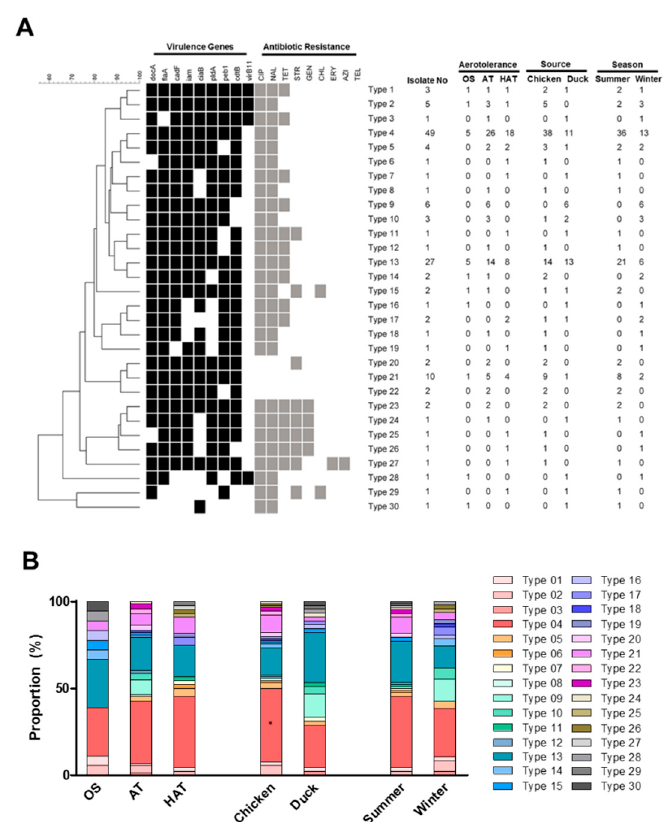
Microorganisms 2019 , 7 , x FOR PEER REVIEW Figure 2. The virulence gene prevalence and antibiotic resistance (Viro and AMR) types of 135 C. jejuni isolates from retail chicken and duck meats in Korea ( A ) and the distribution of different Viro and AMR types depending on aerotolerance (OS: oxygen-sensitive, AT: aerotolerant, HAT: hyper-aerotolerant), origin (chicken or duck meats), and the season (summer or winter) ( B ). *: p < 0.05.